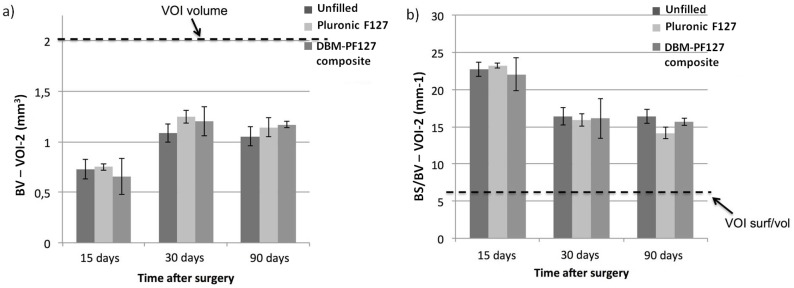
Quantitative results of bone repair as obtained with ex vivo micro-CT in VOI-2.In (a), the dashed line represents the total volume in the VOI-2 (2 mm3) which is the limit for 100% repair, whereas in (b) it is the minimum value of BS/BV for that VOI-2 (6.6 mm–1) that is only obtained when the VOI-2 is fully occupied by compact bone.